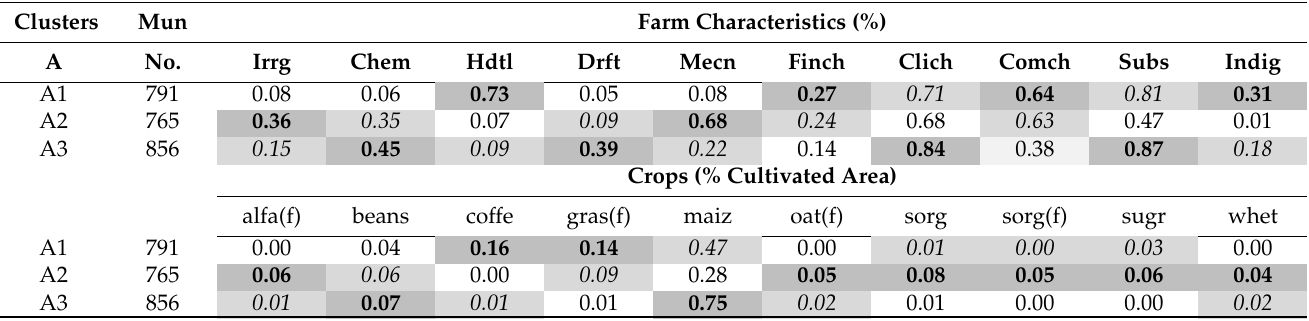
Table 2. Variable means in each cluster (A), shaded by ordered rank, with highest (bold), middle (italics), and lowest (none)